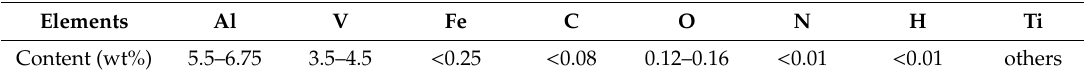
Table 3. Normalizing treatments: Lists of